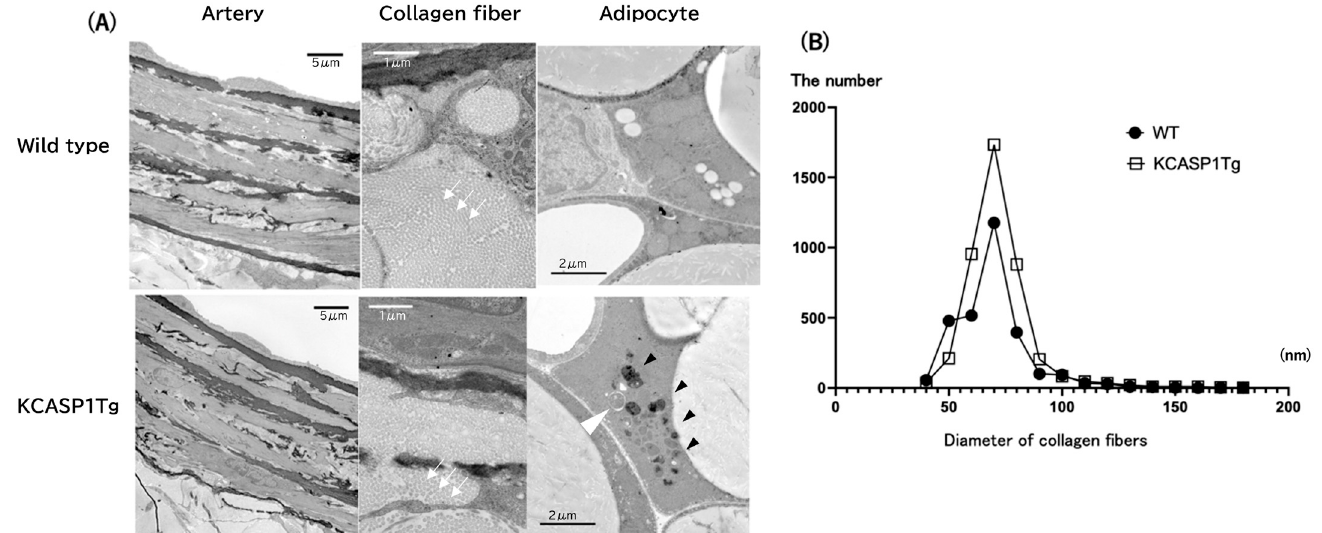
Figure 2. Electron microscopic study for abdominal aorta and peri-aortic adipose tissue. No morphological abnormalities were detected in the endothelial cells, smooth muscle, elastic fibers, or fibroblasts of the outer membrane in both of KCASP1Tg, and WT mice. The white arrow shows each collagen bundle. The adipocytes contained abnormal lysosomes (black arrowhead) and an autophagy-like structure in KCASP1Tg mice (white arrowhead), ( A ). The diameter of collagen fibers in the outer membrane shows a similar pattern between KCASP1Tg, and WT mice ( B